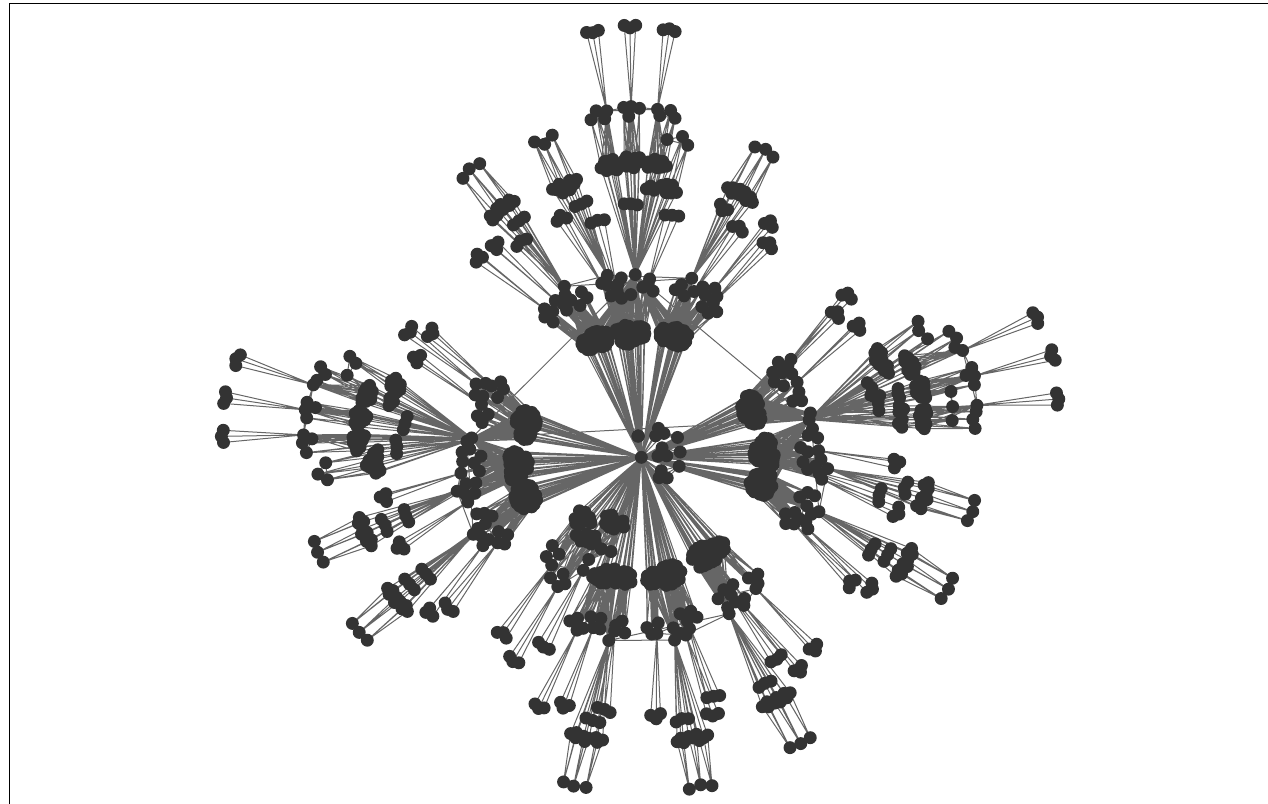
FIGURE 2 | Hierarchical graph with N = 1024 nodes obtained from the iterative scheme described in Ravasz et al. (2002) and sketched on Figure